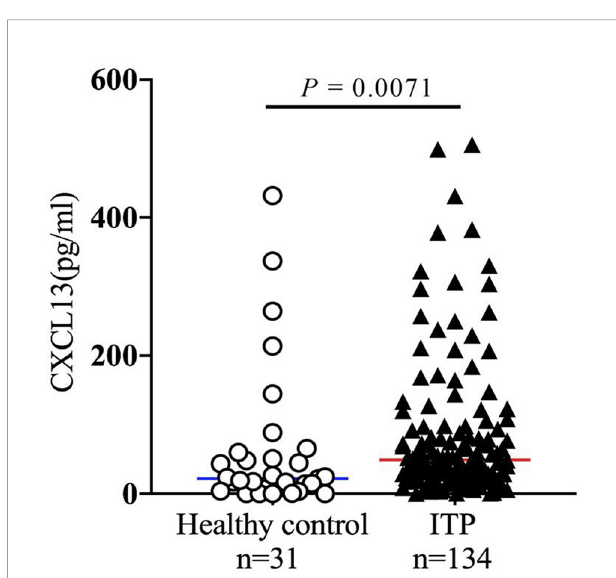
FIGURE 4 | ChemokineCXCL13expressioninpatients withITP.Plasmasamples wereisolatedfrom healthyvolunteers andITPpatients. Theplasmaconcentrationof